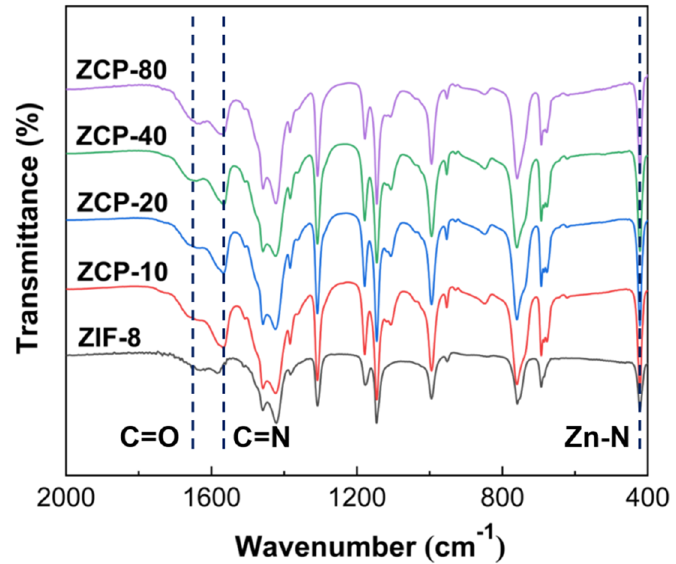
Figure 2. FT-IR spectra of ZIF-8 and ZCPs.